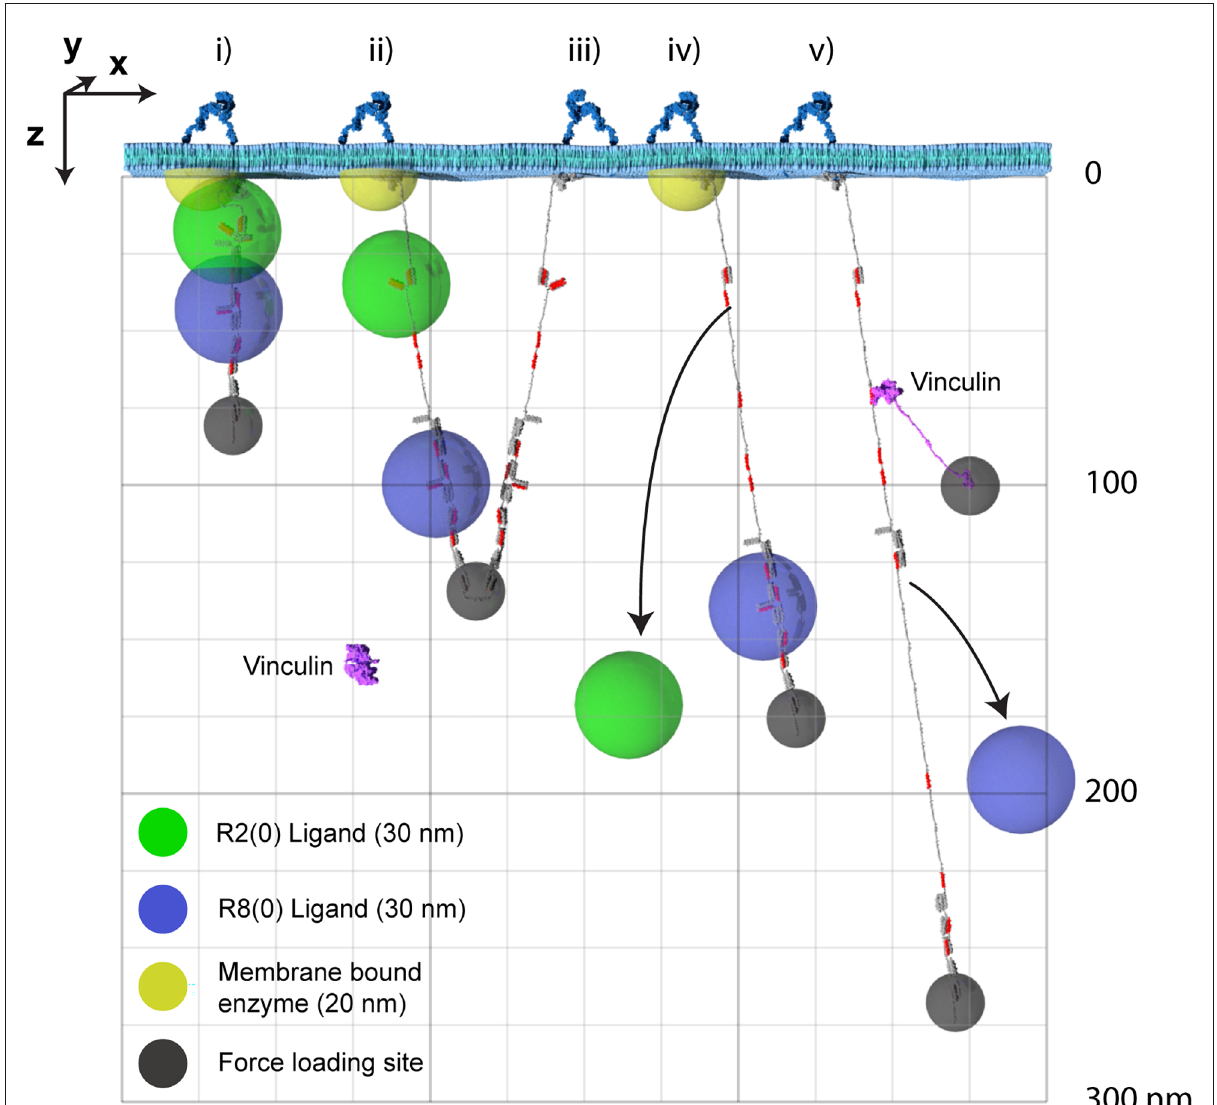
FIGURE4 The MeshCODE defines a 3D Venn diagram of molecules spatially resolved in the z-dimension. The x- and y-dimensions are the plane of the membrane with z- being the axis away from the membrane. For clarity only two dimensions, x- and z- are shown. Five talin molecules are shown drawn to scale and in different states (i–v). The yellow hemisphere is a membrane tethered enzyme or substrate. The green/blue spheres represent ligands engaging the MeshCODE and illustrate the zones of activity of molecules engaging the switches. The green sphere is an R2(0) ligand, the blue sphere is an R8(0) ligand, and the small dark grey spheres represent the mechanical attachments exerting the pulling force in the z-dimension. A single vinculin is drawn, autoinhibited in the cytosol and then bound to a VBS in R2(1). Each molecule has a fixed location which can be given Cartesian x, y, z coordinates relative to the fixed origin position defined by the ECM-integrin-talin connection. In some switch states these spheres overlap, but as the switch patterns change, the positions of each sphere are changed relative to each other. For clarity we only show the result of three switches opening as additional switches opening would exceed the page height at this scale. Many talin ligands are enzymes or known enzyme substrates, so where these spheres overlap the enzymatic activity will be high, and where they are held apart the activity will be low. The size of the spheres where each ligand is active will be dictated by the properties of the ligand but the locations of the spheres relative to each other will be a function of the switch